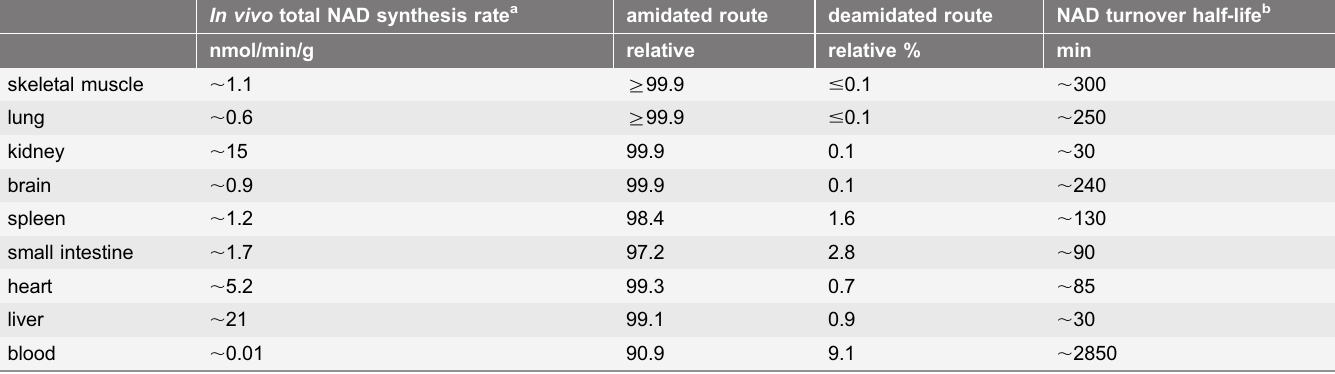
Table 4. Estimated rates of total NAD synthesis (‘‘amidated’’ plus ‘‘deamidated’’) in mouse tissues. In vivo total NAD synthesis rate